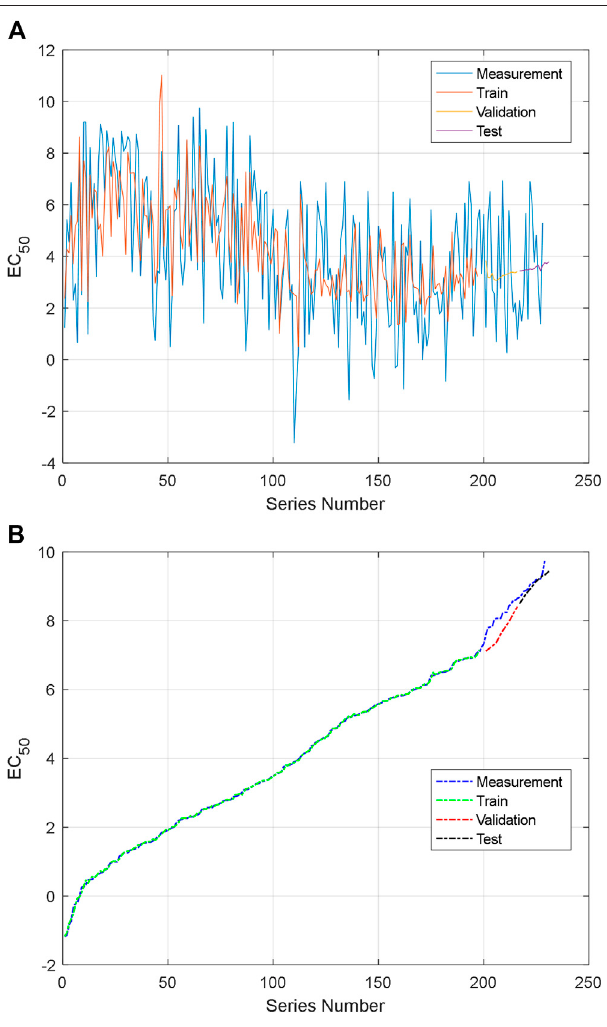
FIGURE 11 | Training and testing data: (A) the fi rst NARXNN prediction for the fi rst group series and (B) the second NARXNN prediction for the second group series.